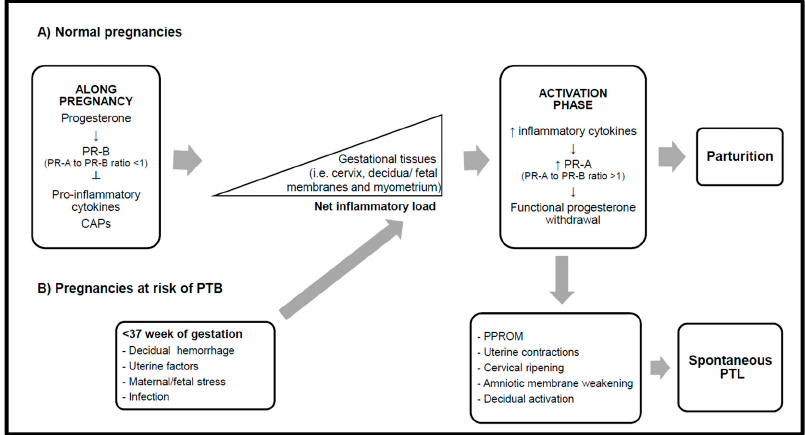
Figure 1. Parturition cascade in normal term and preterm pregnancies. PR-A and PR-B: progesterone receptors A and B, respectively; CAPs: contraction-associated proteins, PTL: preterm labor; PTB: preterm birth; PPROM: preterm premature rupture of membranes.